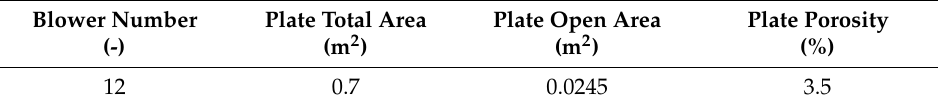
Table 2. Main geometric parameters of the hot air blowers.